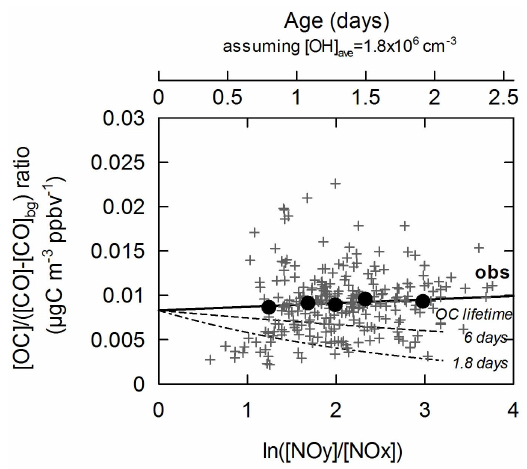
Fig. 11. 1 [OC]/ 1 [CO] ratio during the latter period of the cam- paign (from 16 June 2006), without influence from biomass burn- ing, plotted against ln([NO y ]/[NO x ]) (lower x axis) and the con- verted air mass age (upper x axis), calculated with the average OH concentrations during this period. The CO background concentra- tion, [CO] bg , was assumed to be 90ppbv. Dashed line and dashed- dotted line represent the theoretical decays with assumed OC life- times of 6 and 1.8 days,